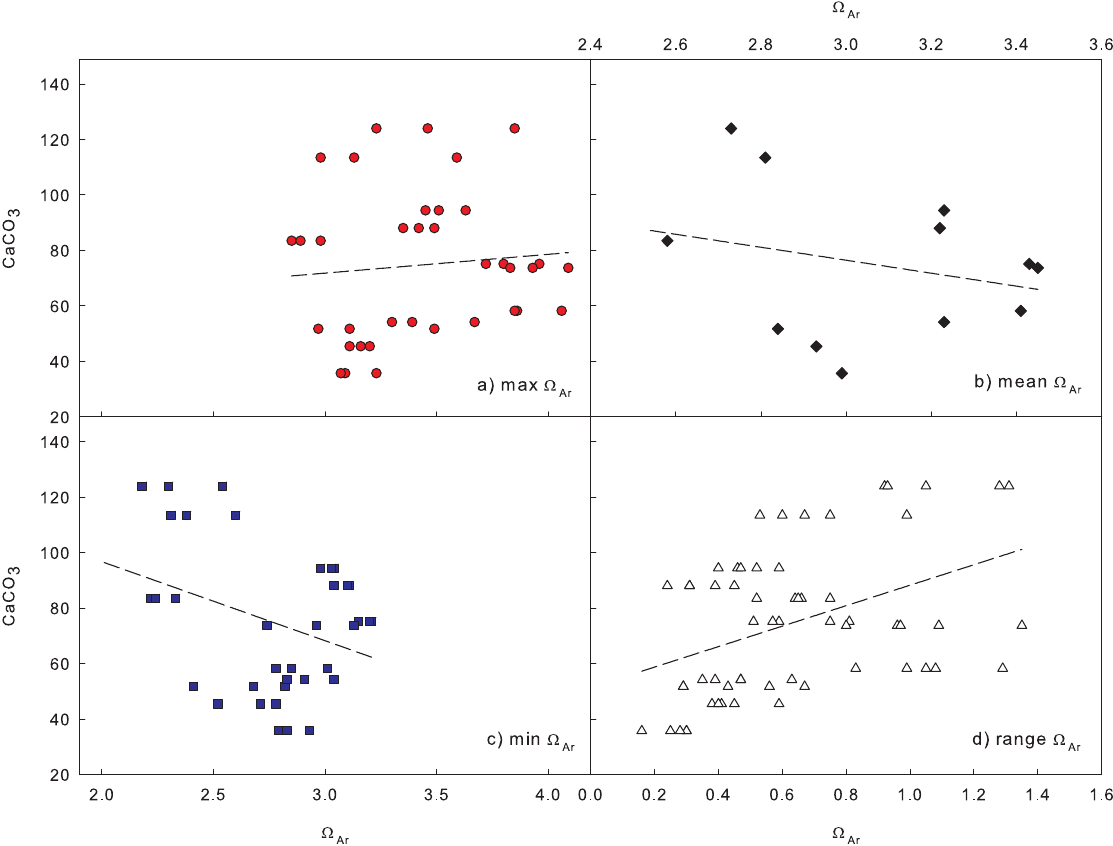
Fig. 6. Calcium carbonate content of the leaves vs. the saturation state of Aragonite ( (cid:127) Ar ) in the meadow. The linear regression is described as CaCO 3 = 20 . 12 (cid:127) Ar − 16 .